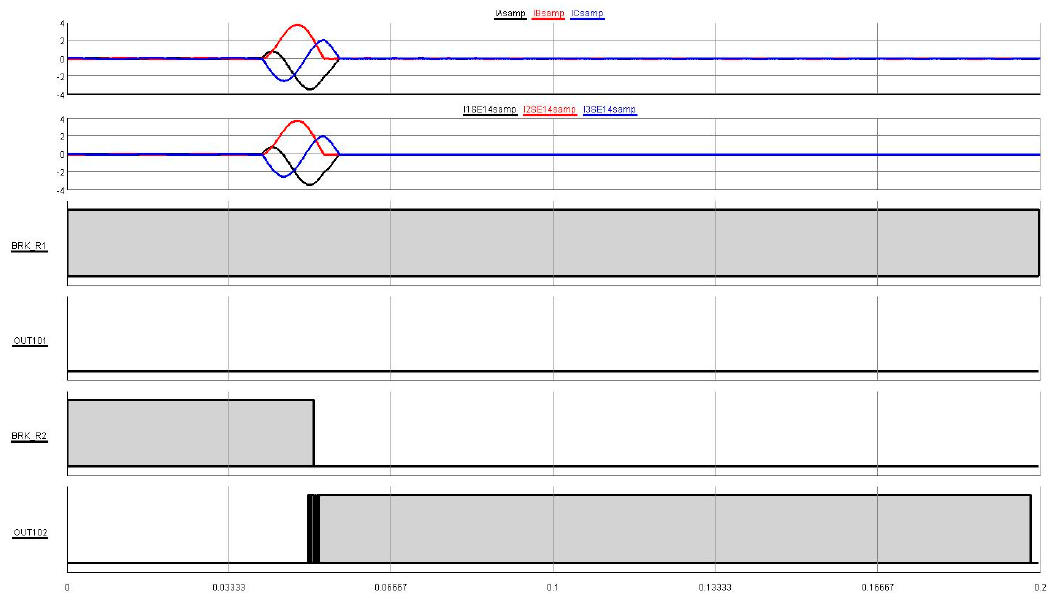
Figure 24. Waveforms for fault condition when R2 operates—case 1.